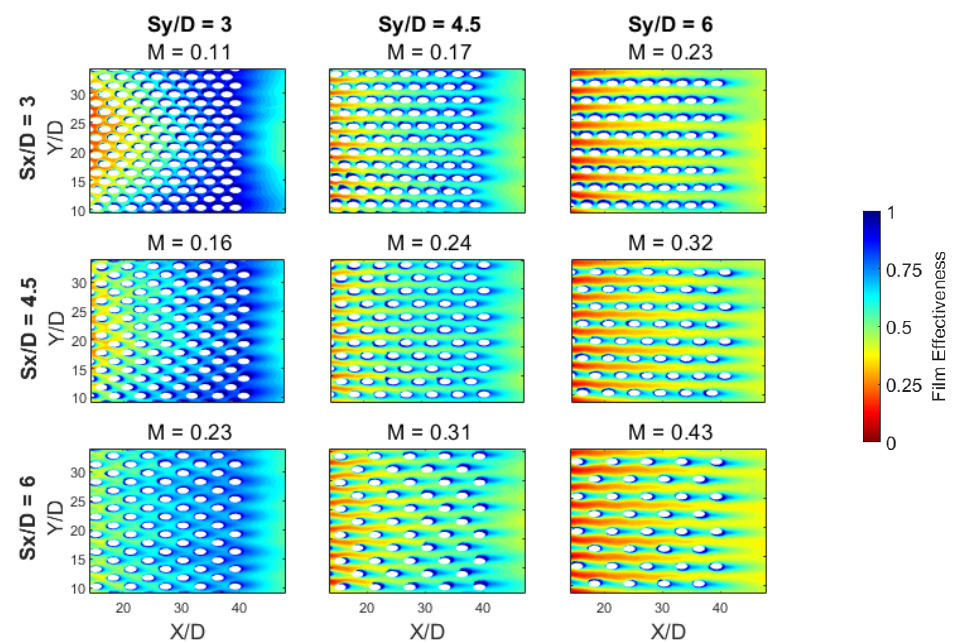
Figure 11. Experimental film effectiveness contours for m ∗ ≈ 1.8. The blowing ratio ( M ) of each geometry is displayed above each contour plot. In general, increased porosity results in a more uniform film coverage.